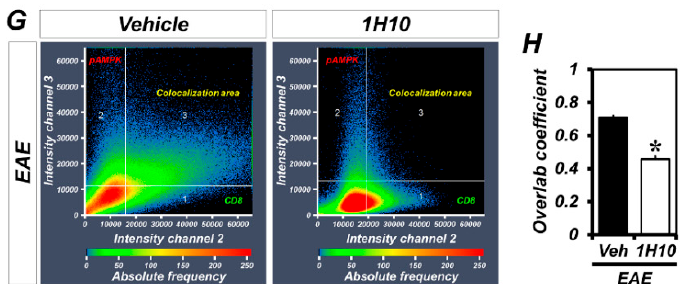
Figure 5. 1H10 treatment inhibits EAE-induced immune cell infiltration into the white matter of the spinal cord and the phosphorylation of AMP-activated protein kinase (AMPK) in infiltrated CD8 + T cells. ( A ) Representative images showing sections of the spinal cord stained for cresyl violet to detect the infiltration of mononuclear cells. Scale bar, 100 µ m. ( B ) Quantification of infiltrated mononuclear cells from the spinal cord in mice treated with vehicle or 1H10 at 3 weeks following initial immunization (mean ± SEM; n = 5 per group). * p < 0.05 vs. vehicle-treated EAE mice (unpaired Student’s t -test). ( C ) Representative images showing the expression of the T and B cells stained with antibodies against cell surface molecules, such as CD4, CD8, and CD20. ( D , E ) Bar graph showing the intensity ( D ) or percent area ( E ) of CD4, CD8, and CD20 immunoreactivity in the thoracic spinal cord with or without 1H10 treatment in sham-operated and EAE mice (mean ± SEM; n = 4–5 per group). * p < 0.05 vs. vehicle-treated EAE mice; # p < 0.05 vs. sham-operated mice (Kruskal-Wallis test followed by Bonferroni post-hoc test: CD4: Chi square = 14.895, df = 3, p = 0.002; CD8: Chi square = 15.456, df = 3, p = 0.001; CD20: Chi square = 14.842, df = 3, p = 0.002). ( F ) Representative immunofluorescence images showing CD8 + T cells that were co-labeled with the phospho-AMPK α 1 / 2 in the spinal cord from vehicle- and 1H10-treated EAE mice. ( G ) Colocalization scatterplots of CD8 with phospho-AMPK α 1 / 2. ( H ) Quantitative colocalization parameters of CD8 with phospho-AMPK α 1 / 2 determined by measuring Mander’s overlap coe ffi cient (mean SEM; n = 4 per group). * p < 0.05 vs. vehicle-treated EAE mice (unpaired Student’s t -test).